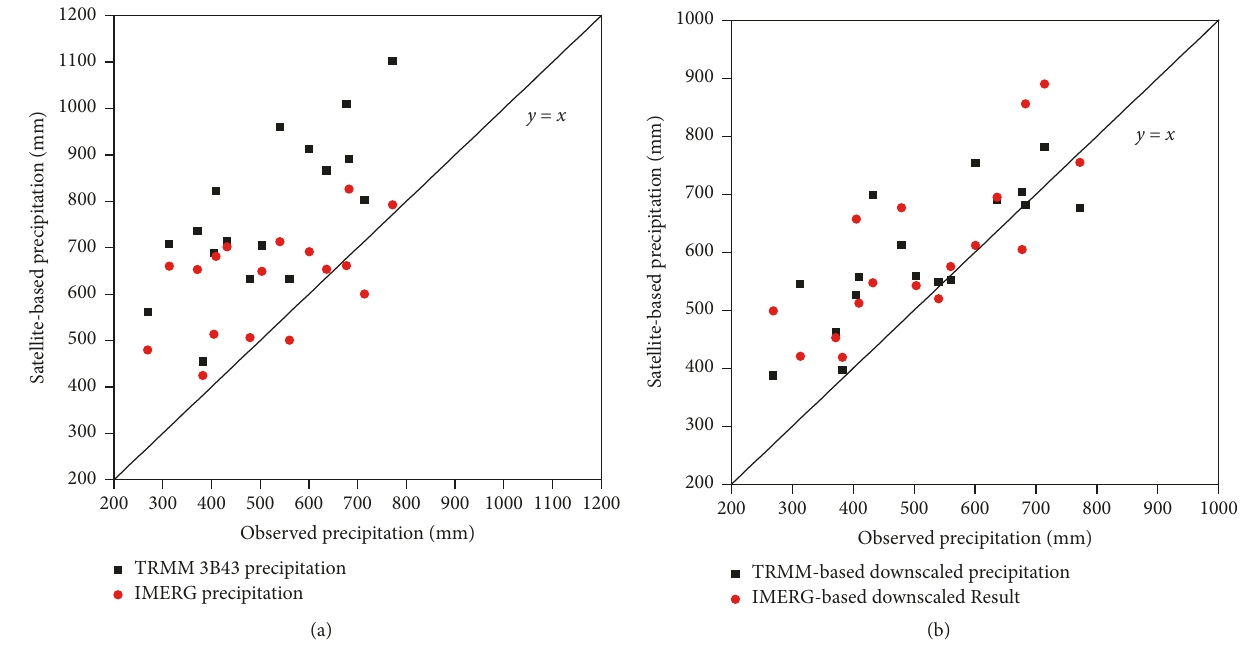
Figure 8: Comparisons between TRMM 3B43 precipitation, IMERG precipitation, and observed precipitation (a) before downscaling and (b) after downscaling for